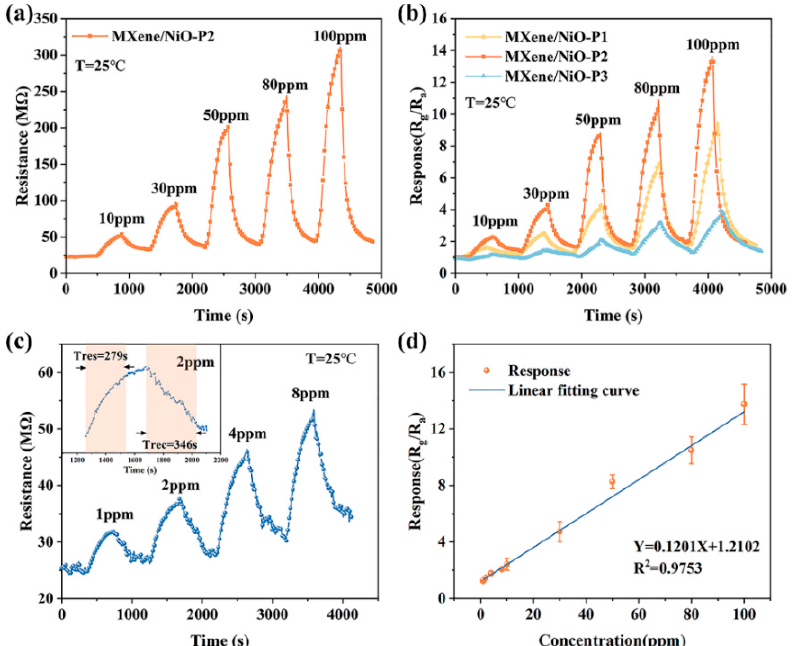
Figure 6. ( a ) Real-time resistance changes in the sensors based on MXene/NiO-P2 to 10–100 ppm HCHO at 25 °C. ( b ) Response changes in the sensors based on MXene/NiO-P1, MXene/NiO-P2, and MXene/NiO-P3 to 10–100 ppm HCHO at 25 °C. ( c ) Real-time resistance changes in the MXene/NiO- P2 sensor to the low concentrations (1–8 ppm) of HCHO at 25 °C. ( d )The response fi tt ing curves of the MXene/NiO-P2 sensor to 1–100 ppm HCHO at 25 °C.